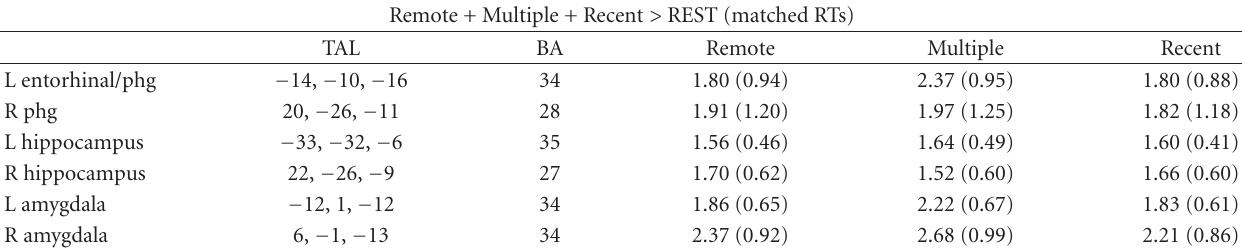
Table 7: Mean e ff ect sizes (standard error of the mean) within the MTL for the three retrieval conditions compared to REST at P < .01 matching RTs. No paired comparisons were significant. Noted are Talairach coordinates (TAL) and Brodmann’s areas (BAs) referencing the center of the activation cluster. The results of various paired sample t -tests are also reported below the table (parahippocampal gyrus,